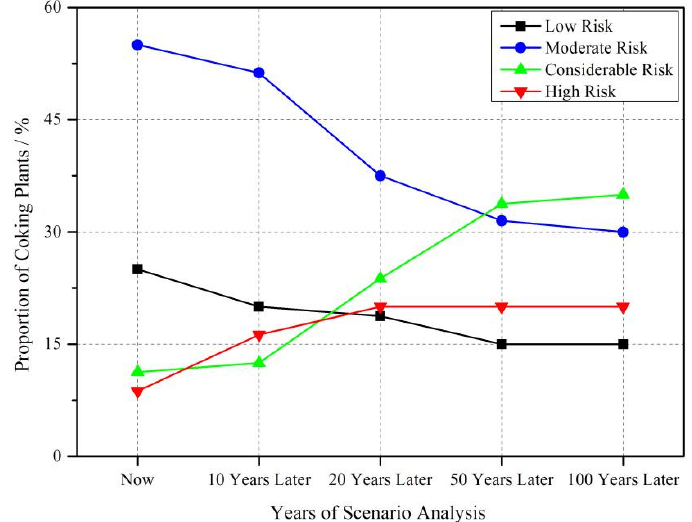
Figure 8. Scenario analysis of potential ecological risk of each coking plant in BTH.